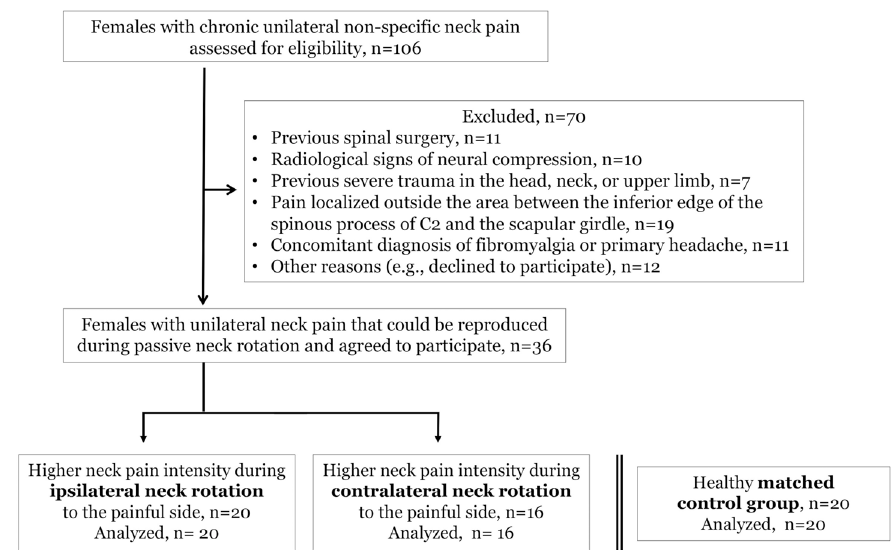
Figure 1. Flowchart diagram of the study participants.